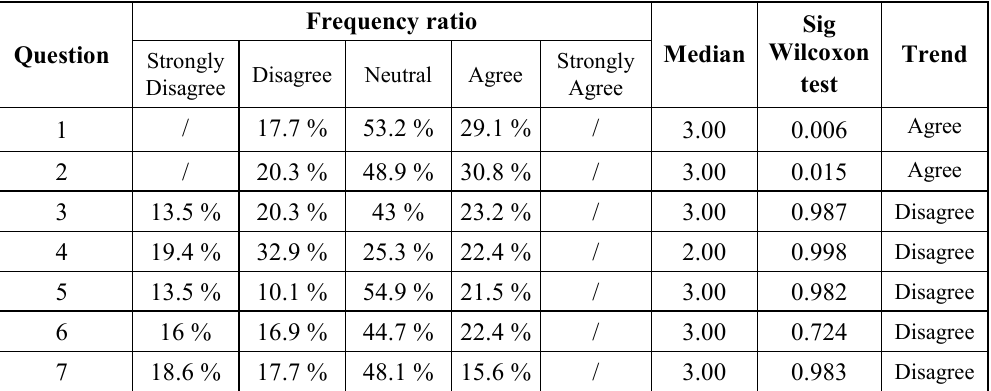
Table 5. Results of the First